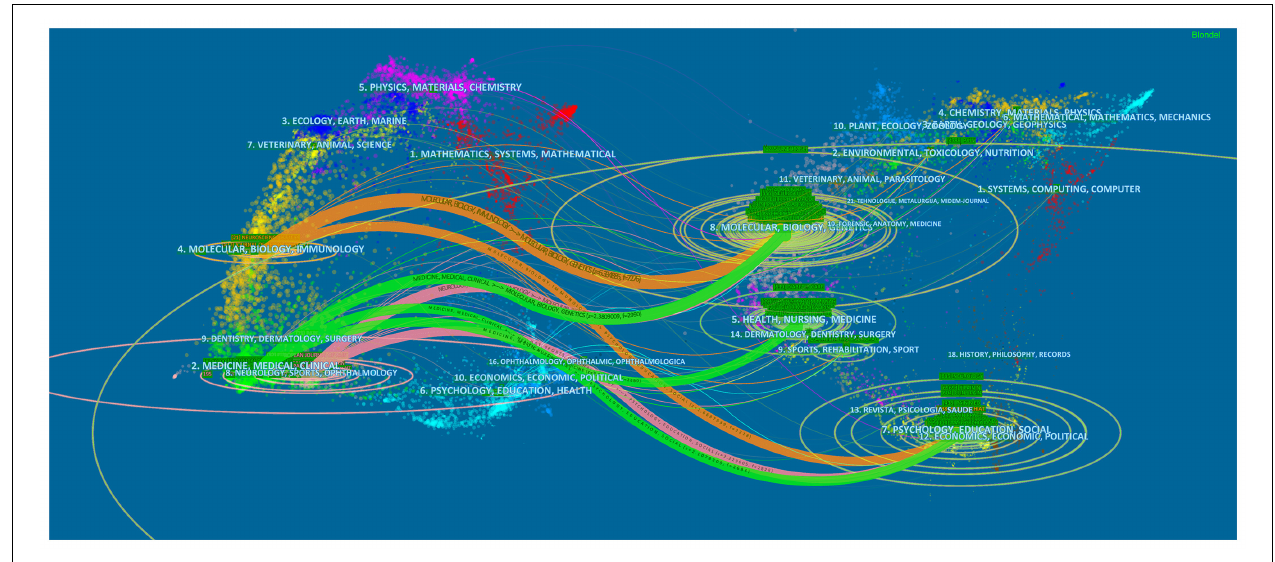
FIGURE 4 | The dual-map overlay of journals related to NP associated with anxiety or depression